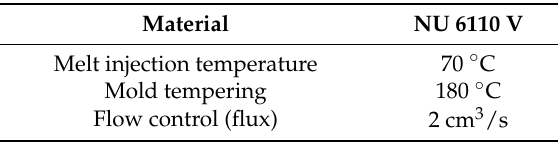
Table 3. Inputs used for the simulation.